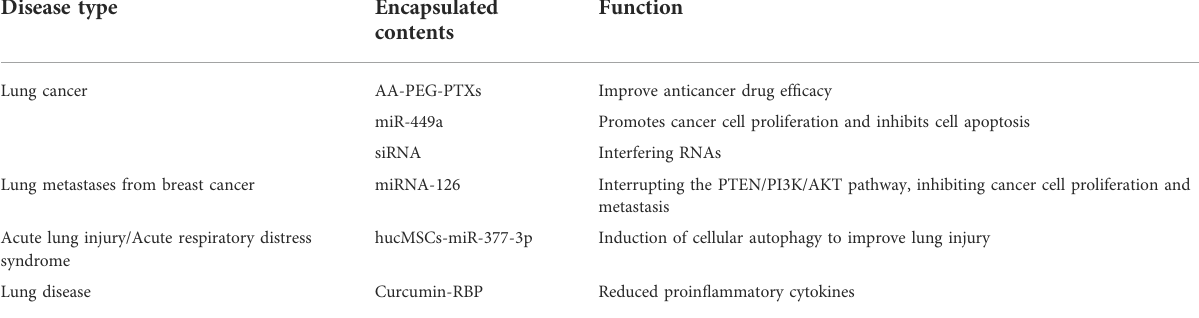
TABLE 1 Engineered exosomes in the respiratory system.